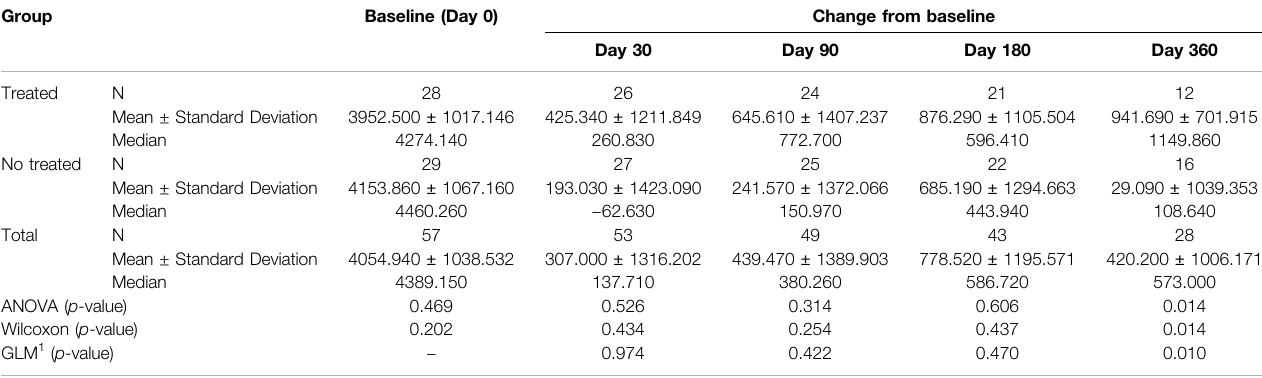
TABLE 4A | (part 1 of 5). GAIT parameters cohort without outliers. Area Vertical Force. General Linear Model with Area Vertical Force change from baseline as dependent variable, treatment as factor, and Area Vertical Force baseline value as covariate. Group